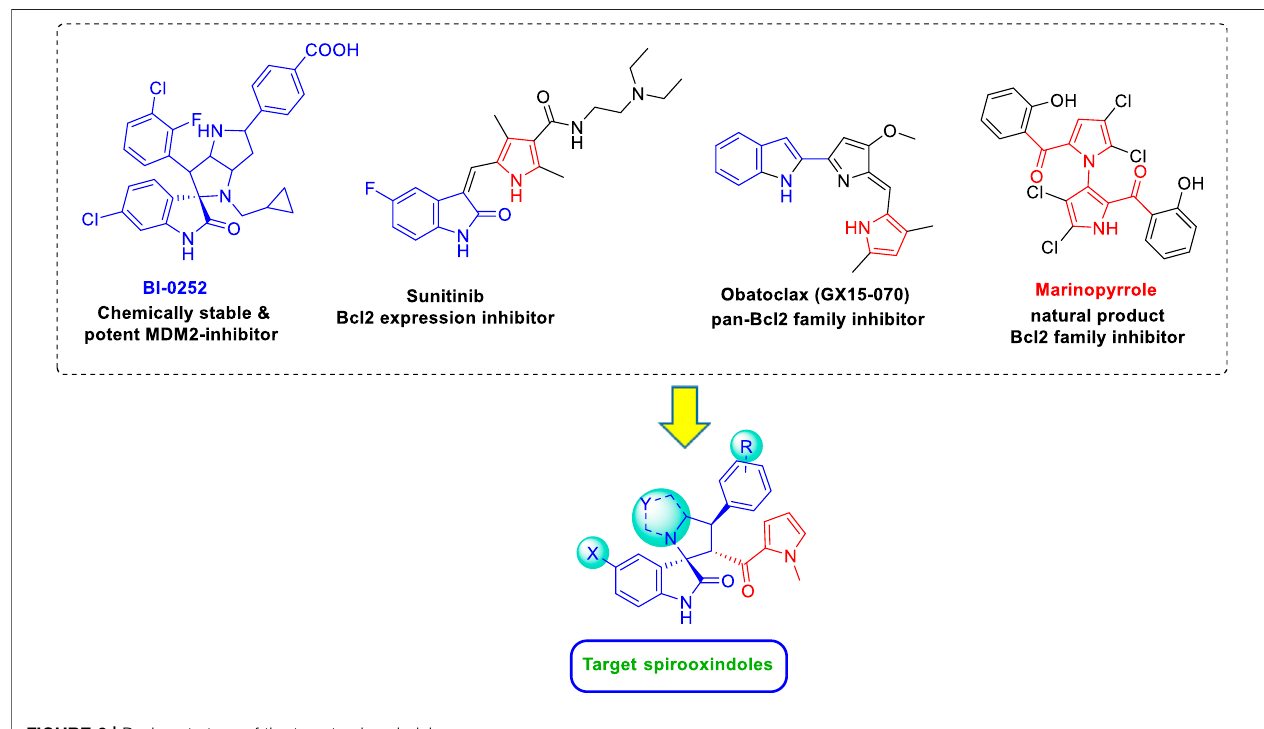
FIGURE 2 | Design strategy of the target spirooxindoles.